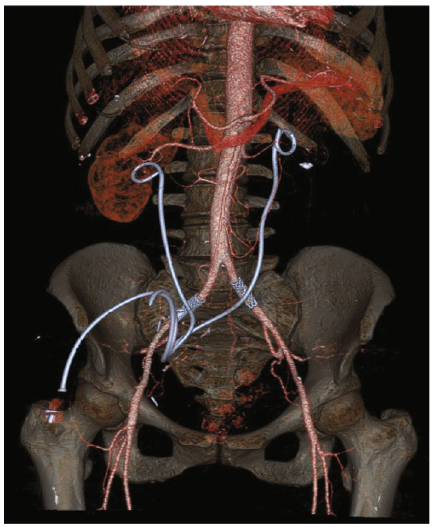
Figure 2: Three-dimensional abdominal CT scan that demonstrated bilateral iliac artery endoprosthesis and ureteral stents (axial evaluation).